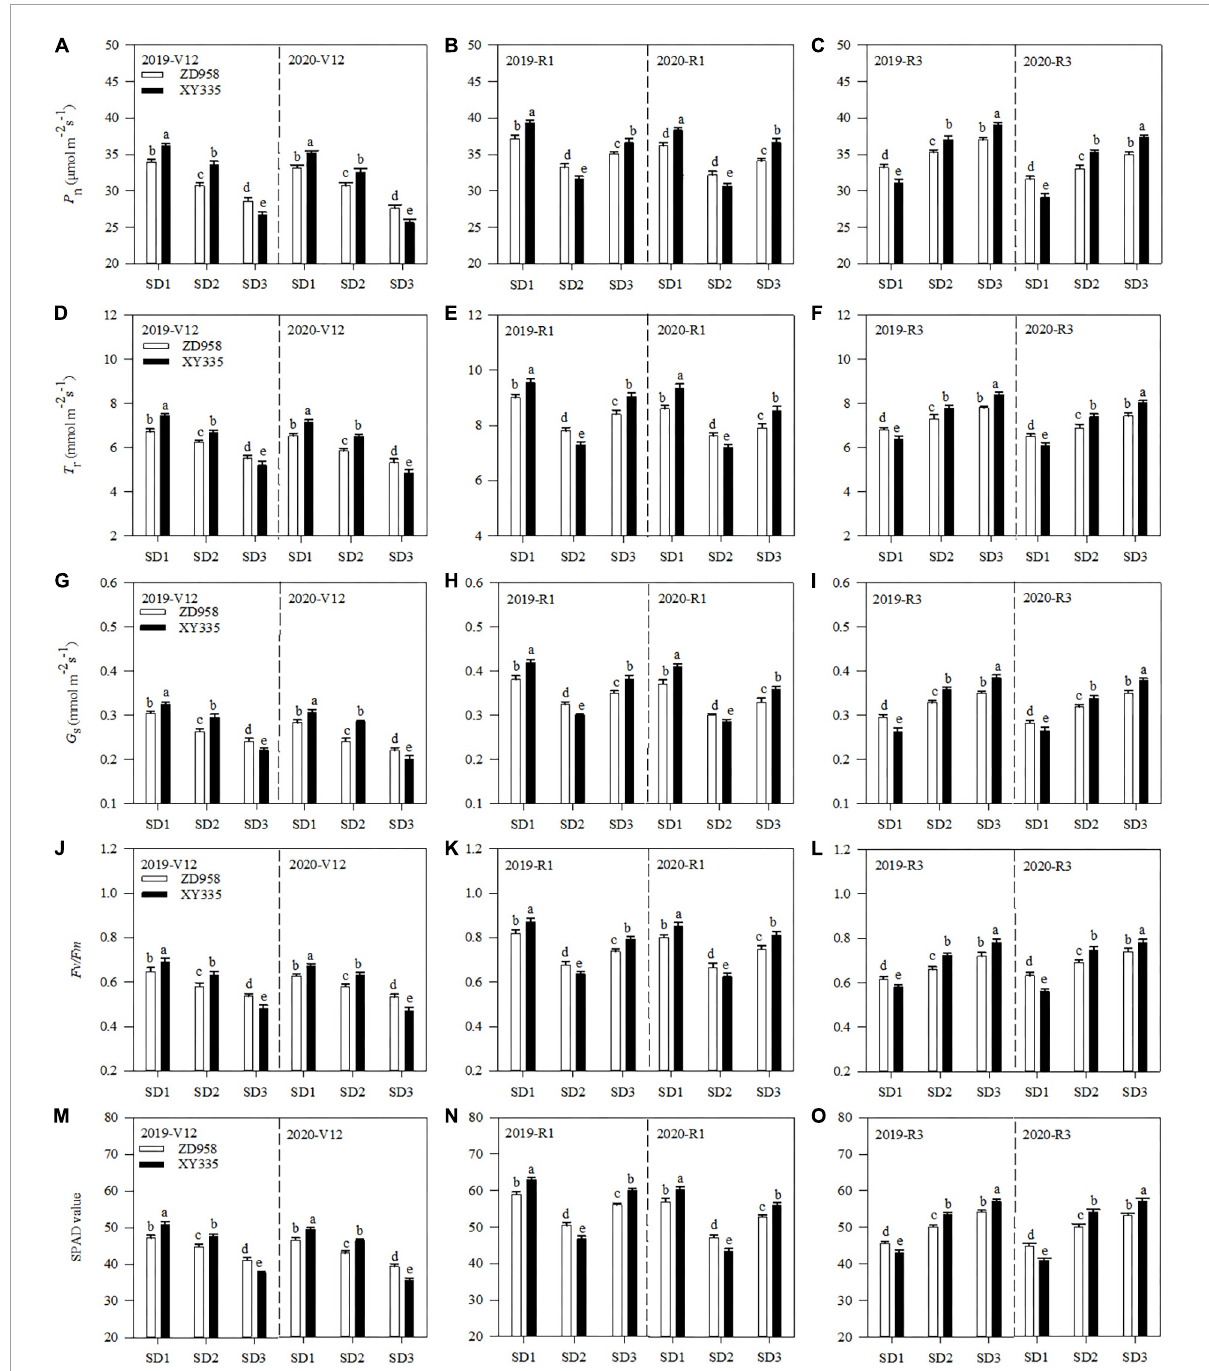
FIGURE2 P n (A–C) , T r (D–F) , G s (G–I) , F v /F m (J–L) , and SPAD (M–O) values of maize ear leaf at V12, R1, and R3 stages under different sowing dates in 2019 and 2020. SD1, early sowing; SD2, conventional sowing; SD3, delay sowing; P n , photosynthetic rate; T r , transpiration rate; G s , stomatal conductance; F v /F m , chlorophyll fluorescence parameters; V12, 12-leaf stage; R1, silking stage; R3, milking stage. Different letters above the error bars indicate significant difference at the 0.05 probability level.